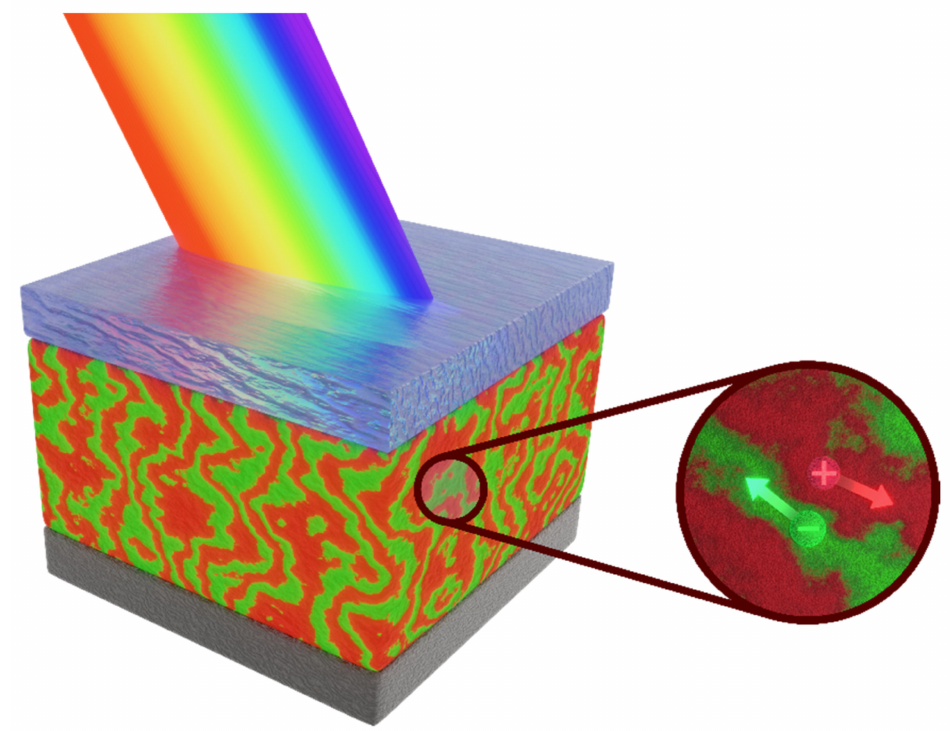
Figure 1. Schematic electron and hole separation in bulk heterojunction photogenerated after illu- mination of the blend. The red and green arrows on the right scheme show the transport route for photogenerated hole and electron,